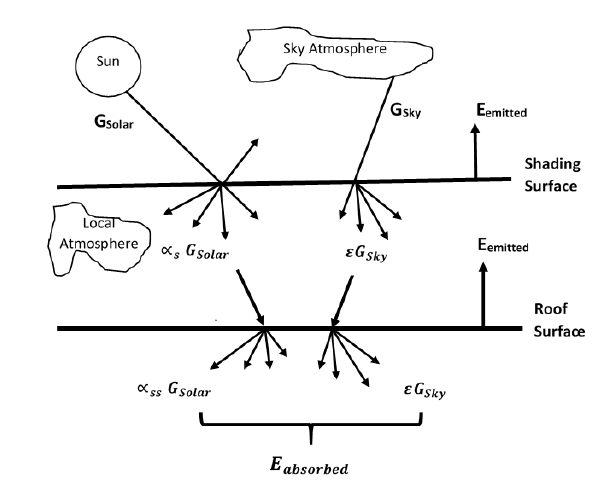
Fig. 10. Radiation interactions of a surface exposed to solar and atmospheric conditions